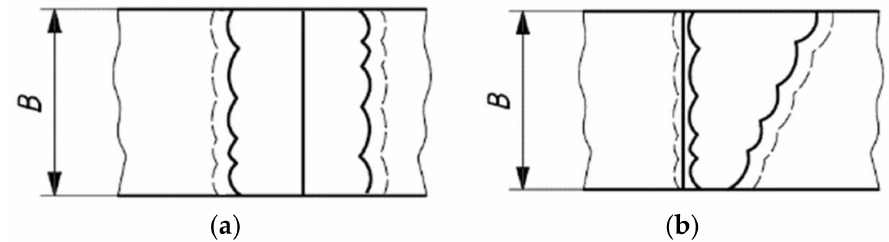
Figure 3. ( a ) Notch location in the fusion zone (FZ) and ( b ) the heat affected zone (HAZ), according to the Standard ISO